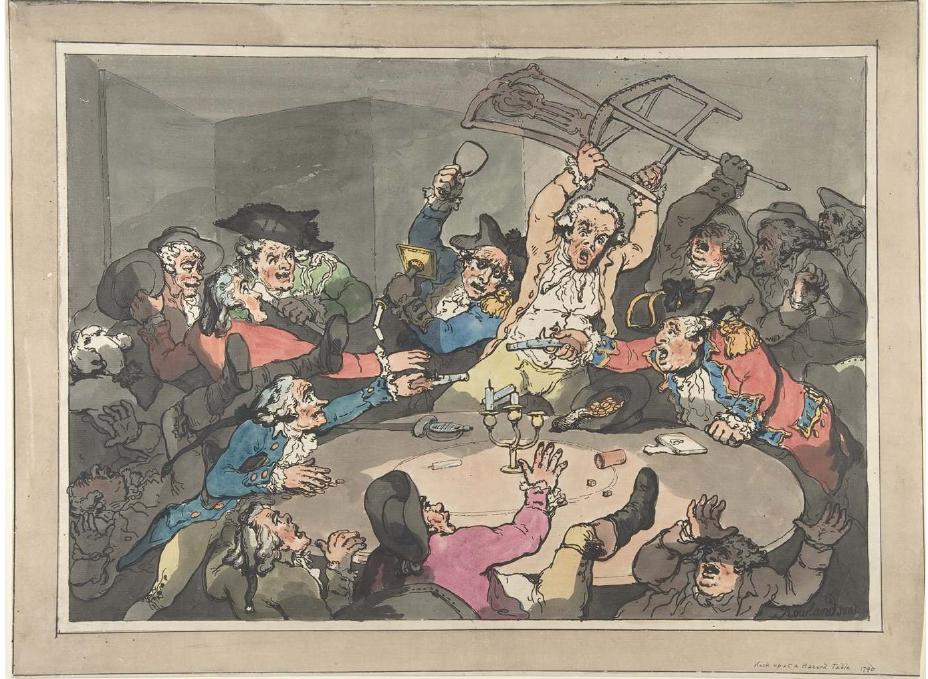
On the satirical side, this English cartoon is a vivid and humorous depiction of the untoward consequences of gambling in a masculine environment. No doubt cheating has been the rule and the stakes have raised high (see the hat fi lled with gold coins). All sorts of objects are wielded around: pistols, a candlestick, a chair, a glass, not to mention the sword on the table. Anything goes to attack one’s adversary. What a shamble! The use of lights and shades is particularly dramatic and ef fi cient in conveying a sense of utter chaos among the participants, coming from different ranks of society. The English of fi cer on the right aims his pistol at an elderly man with a pigtail (a Frenchman), trying to protect his winnings. It is rather ironic that the author of this moralizing picture denouncing the hazards of gambling should have dilapidated his fortune by 1793… Source: New York, Metropolitan Museum of Art. https://www.metmuseum.org/art/collection/search/